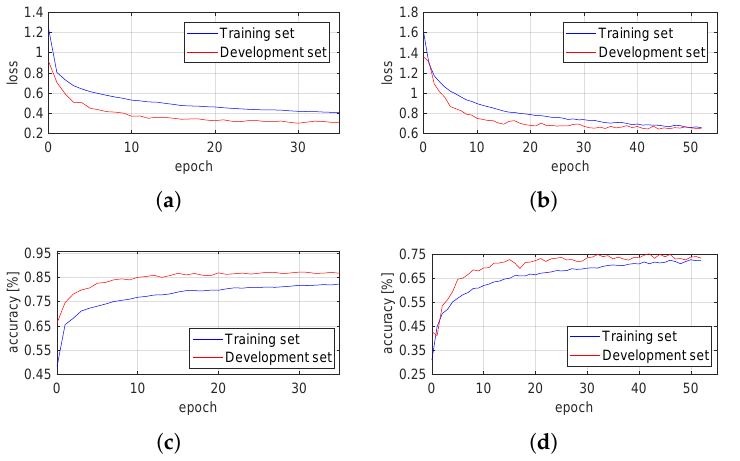
Figure 7. The results for all learning sets for both estimators: horizontal and vertical. ( a ) Loss function (horizontal). ( b ) Loss function (vertical). ( c ) Accuracy (horizontal). ( d ) Accuracy